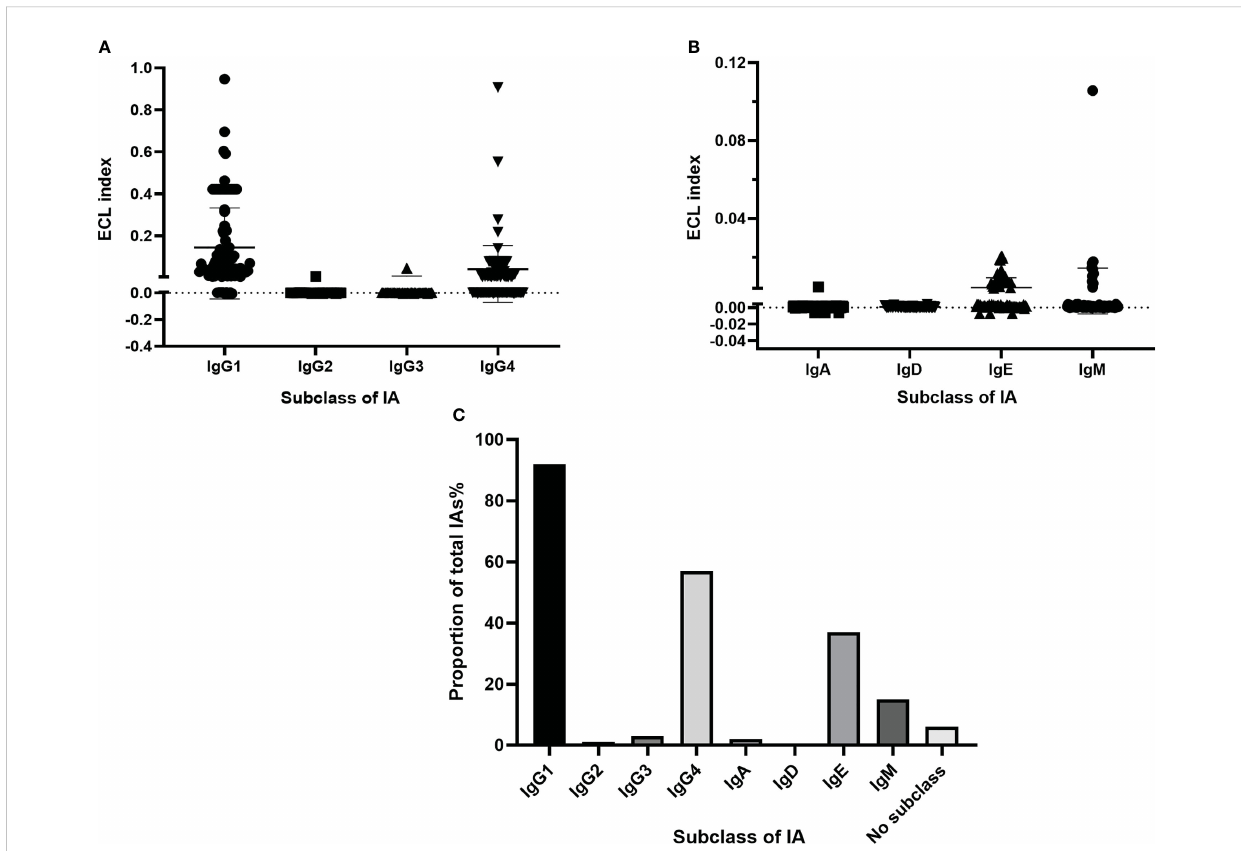
FIGURE 2 Levels (ECL index) of IgG-IA (IgG1-4) (A) and IgA-IA, IgD-IA, IgE-IA, IgM-IA (B) , and frequencies of positivity of different IA isotypes in patients detected positive for total IAs (C) . The solid lines represent median values, and the dotted horizontal lines denote the threshold for positivity. ECL, electrochemiluminescence; IA, insulin